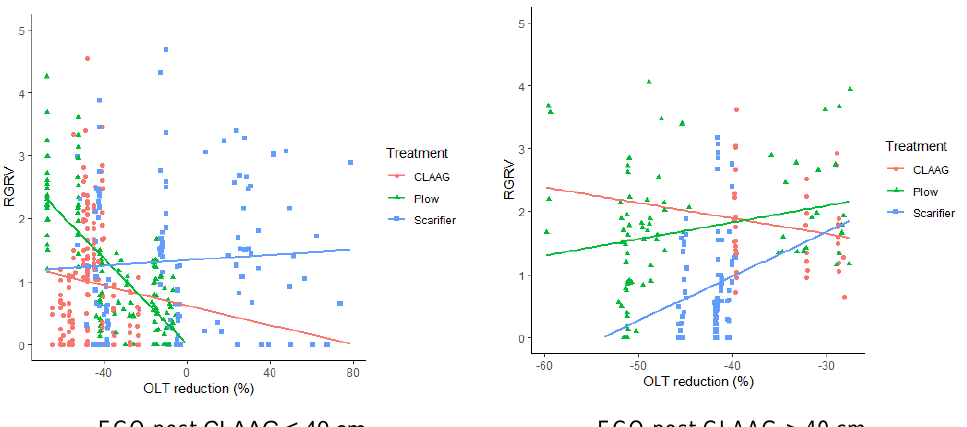
Figure 4. Effect of silvicultural treatments on the relative growth rate in volume index (RGRV) of the seedlings, by post-CLAAG OLT and percent reduction in OLT ( p < 0.001). A negative value of the variable “OLT reduction” means that there was a decrease in OLT; a positive value means an increase in OLT. OLT: organic layer thickness; CLAAG: careful logging around advance growth.